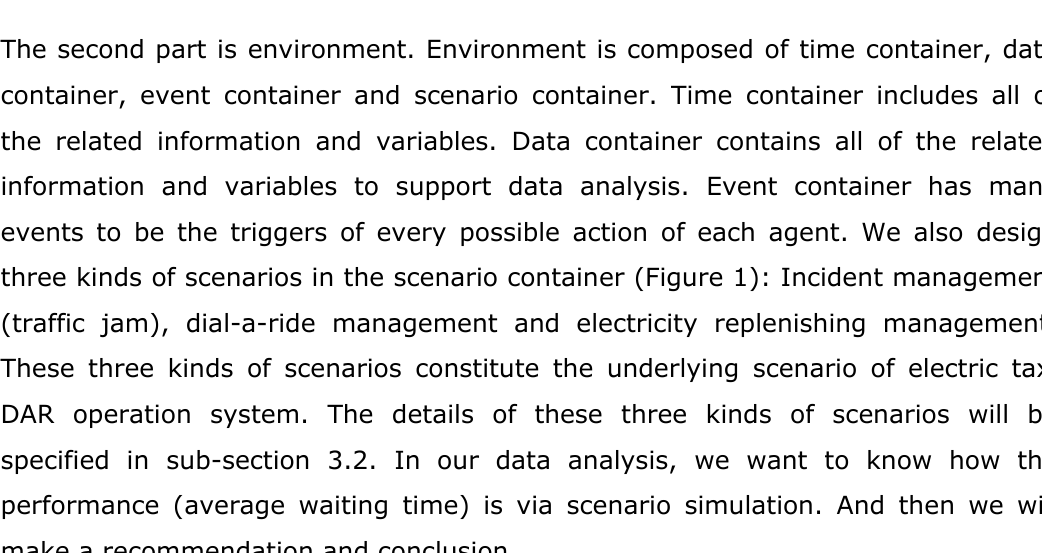
Figure 2. “Passive Agents and Active